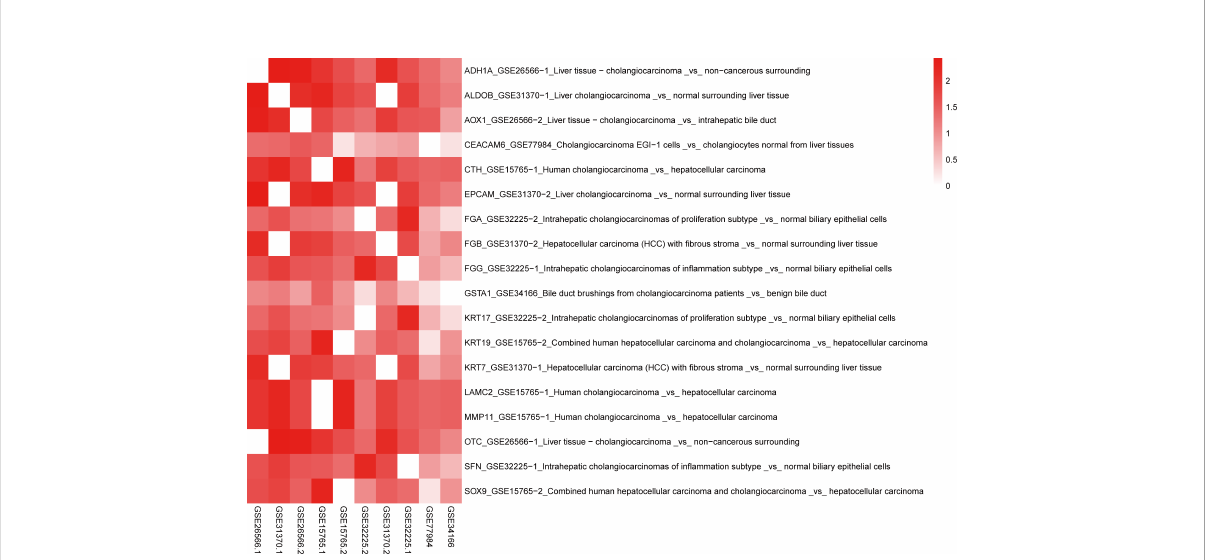
FIGURE 3 Heatmap of 18 DEGs and 10 biosets. Genes that correspond to the same biosets have a value of zero. A higher − log (p-values) corresponds to a higher positive correlation. The format is Gene_GSE bioset_Bioset